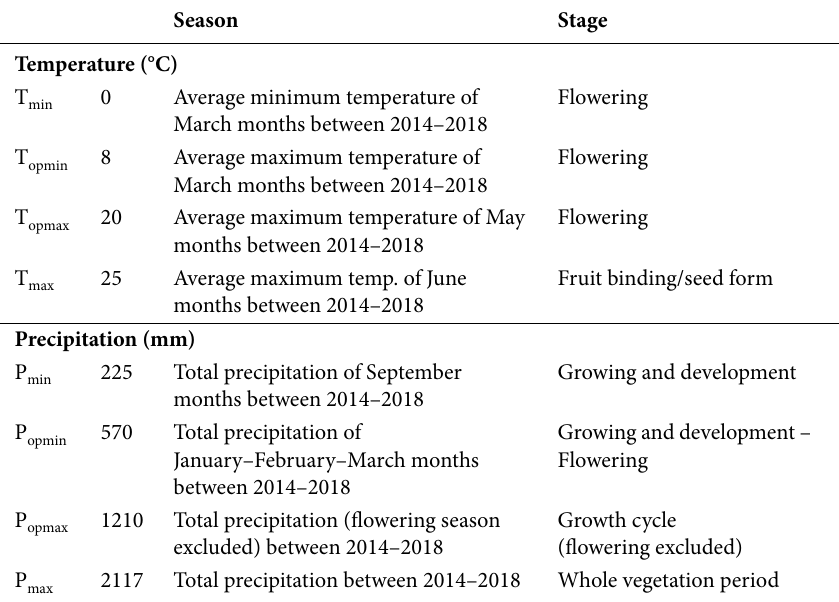
Table 1 Determined temperature and precipitation requirements of Fritillaria imperialis based on the years between 2014 and